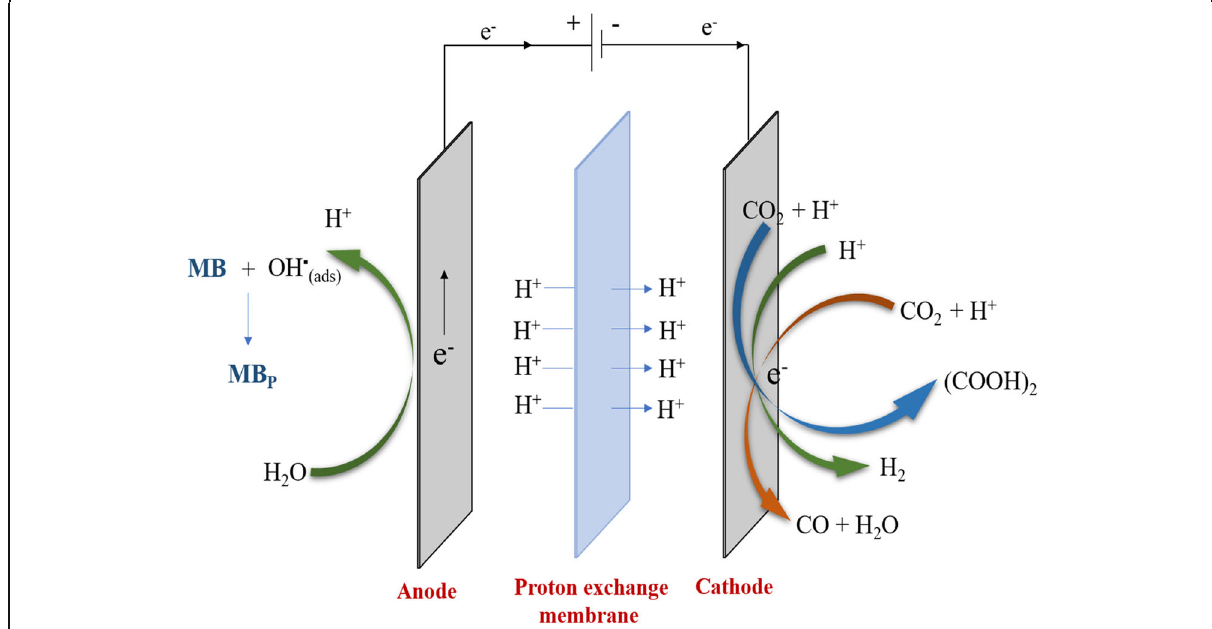
Fig. 6 Schematic diagram of the simultaneous electrochemical oxidation of MB and electrochemical reduction of CO